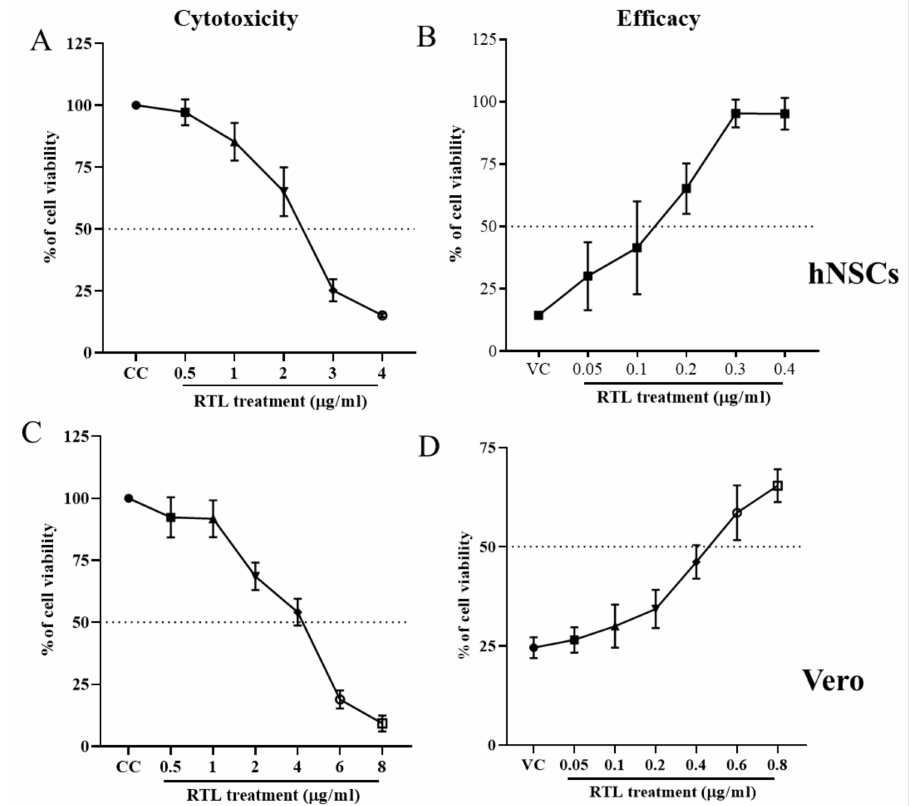
Figure 3. Dose-dependent ( A , C ) cytotoxicity and ( B , D ) anti-viral efficacy of RTL. ( A , B ) hNSCs (2 × 10 4 cells/well) and ( C , D ) Vero cells (1 × 10 4 cells/well) were plated in 96-well plates and treated ( A , C ) with different concentrations of RTL only or ( B , D ) infected with ZIKV (MOI 1) then treated with RTL at different concentrations. DMSO (0.1%) was used as vehicle control at 4 dpi, an MTT assay was carried out and the percentage of cell viability was measured by the formula: (sample absorbance/DMSO absorbance) × 100%. Each data point represents the mean ± SD of six wells combined from two independent